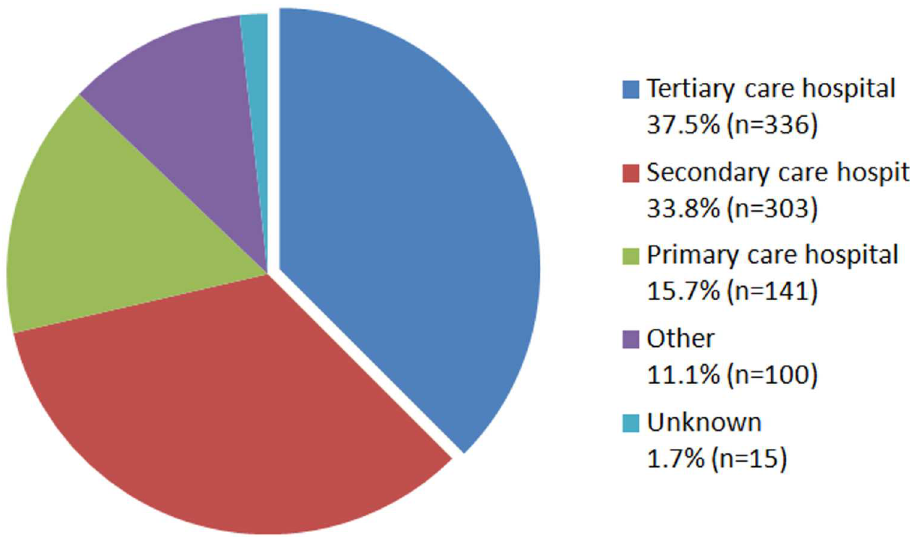
Fig 1. The distribution of hospital care level among hospitals reporting antimicrobial susceptibility and denominator data (subset of all hospitals) to EARS-Net (2013/2014) [6].